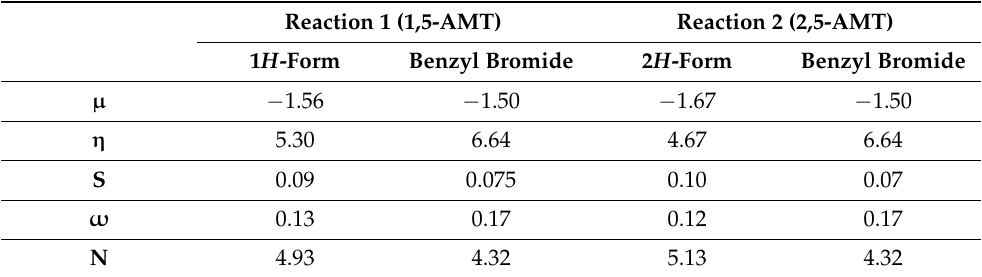
Table 3. Electronic chemical potential µ , chemical hardness η , electrophilicity ω , nucleophilicity N and softness S calculated using DFT/B3LYP/6-31G (d)